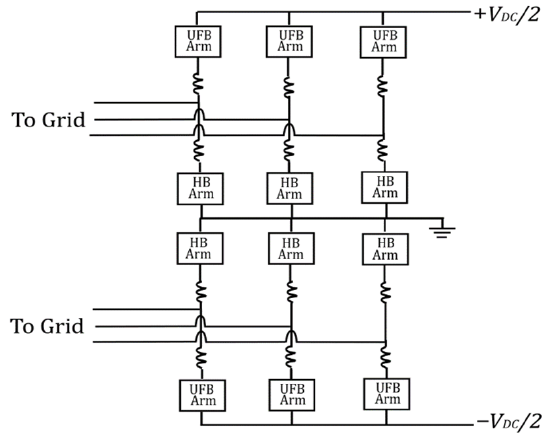
Figure 29. UFBSM-based hybrid arm bipolar MMC.